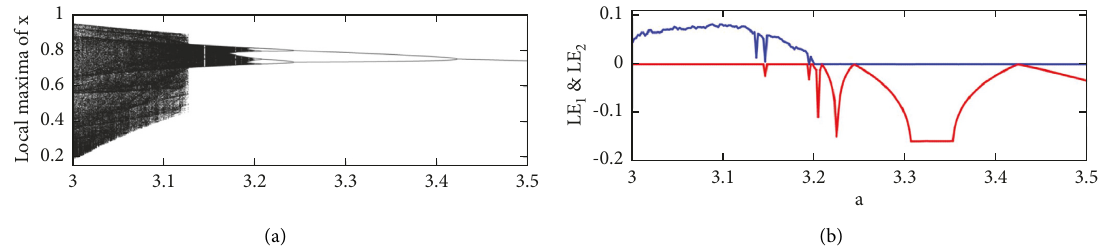
Figure 1: (a) Local maxima of ( x ) showing a typical reverse period-doubling route to chaos and (b) LE.